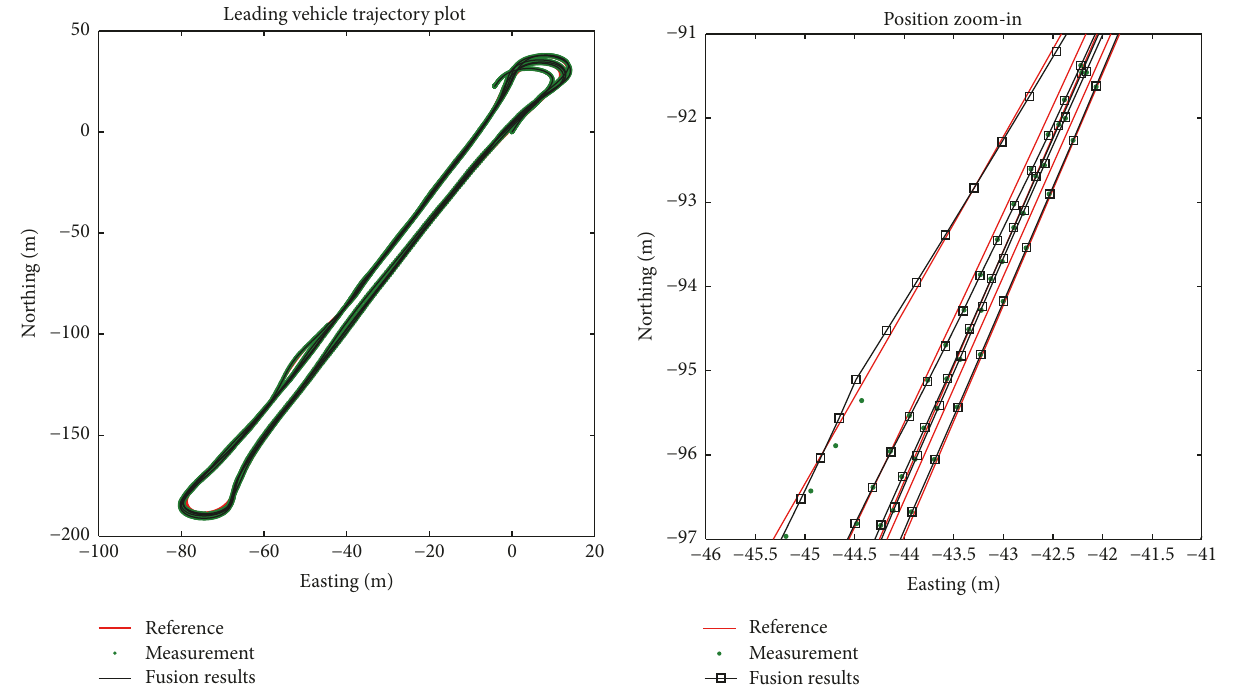
Figure 5: The trajectory of the leading vehicle and the comparison between the fusion results and the measurements with respect to the reference.